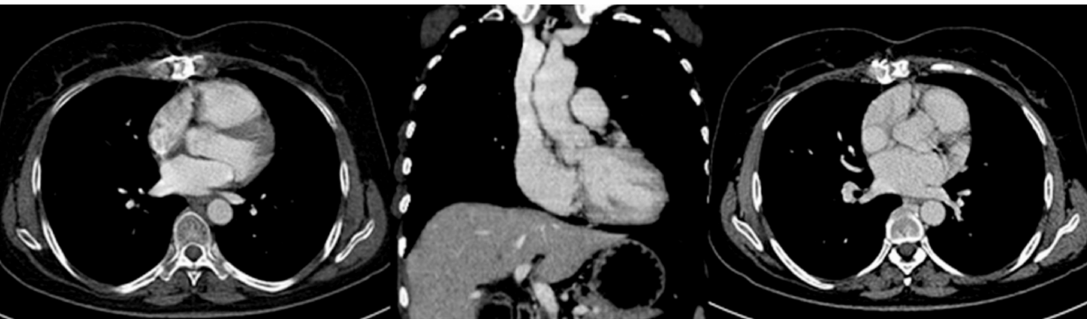
Figure 5. At 14 months, follow-up axial coronal and axial CT images postcontrast enhancement revealed no local